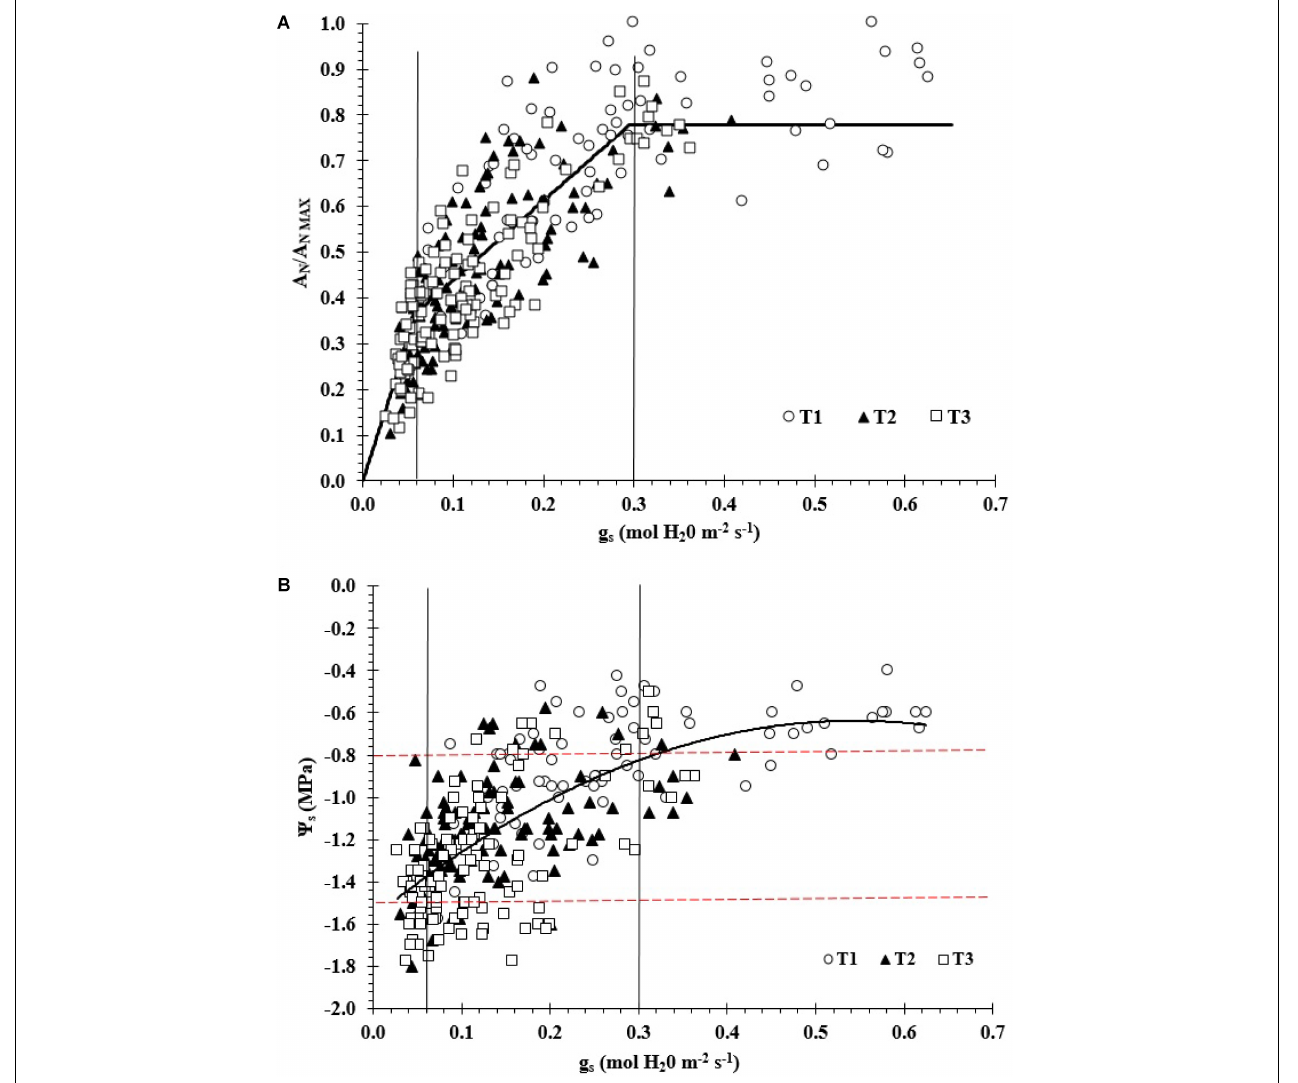
FIGURE 1 | (A) Relationship between A N /A Nmax ratio versus stomatal conductance (g s ) vineyard (A N /A Nmax = 1.02 + 0.25ln(g s ); R 2 = 0.72) and (B) relationship between midday stem water potential ( (cid:57) s ) versus g s in a drip-irrigated Carménère vineyard ( (cid:57) s = –3.157g s2 +3.43g s –1.571; R 2 = 0.5). A N and A Nmax are actual and maximum values of net CO 2 assimilation,